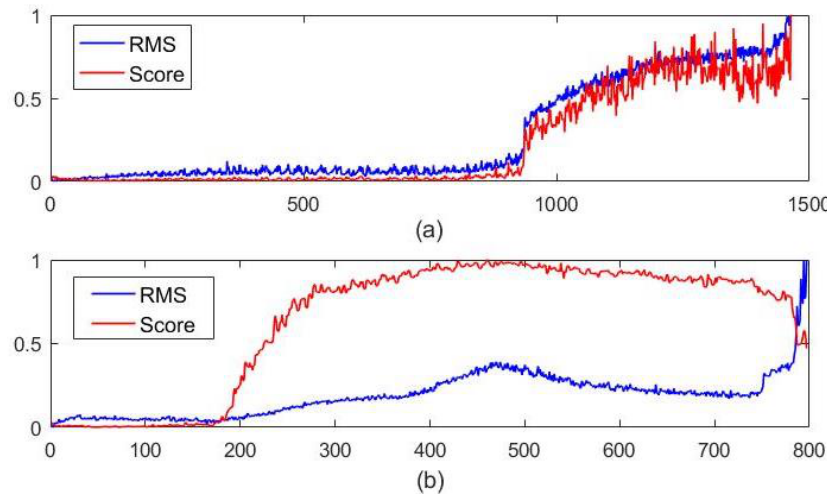
Figure 5. The comparison results of abnormal score and the RMS value with ( a ) XJTU1_1 and ( b ) XJTU 2_2.